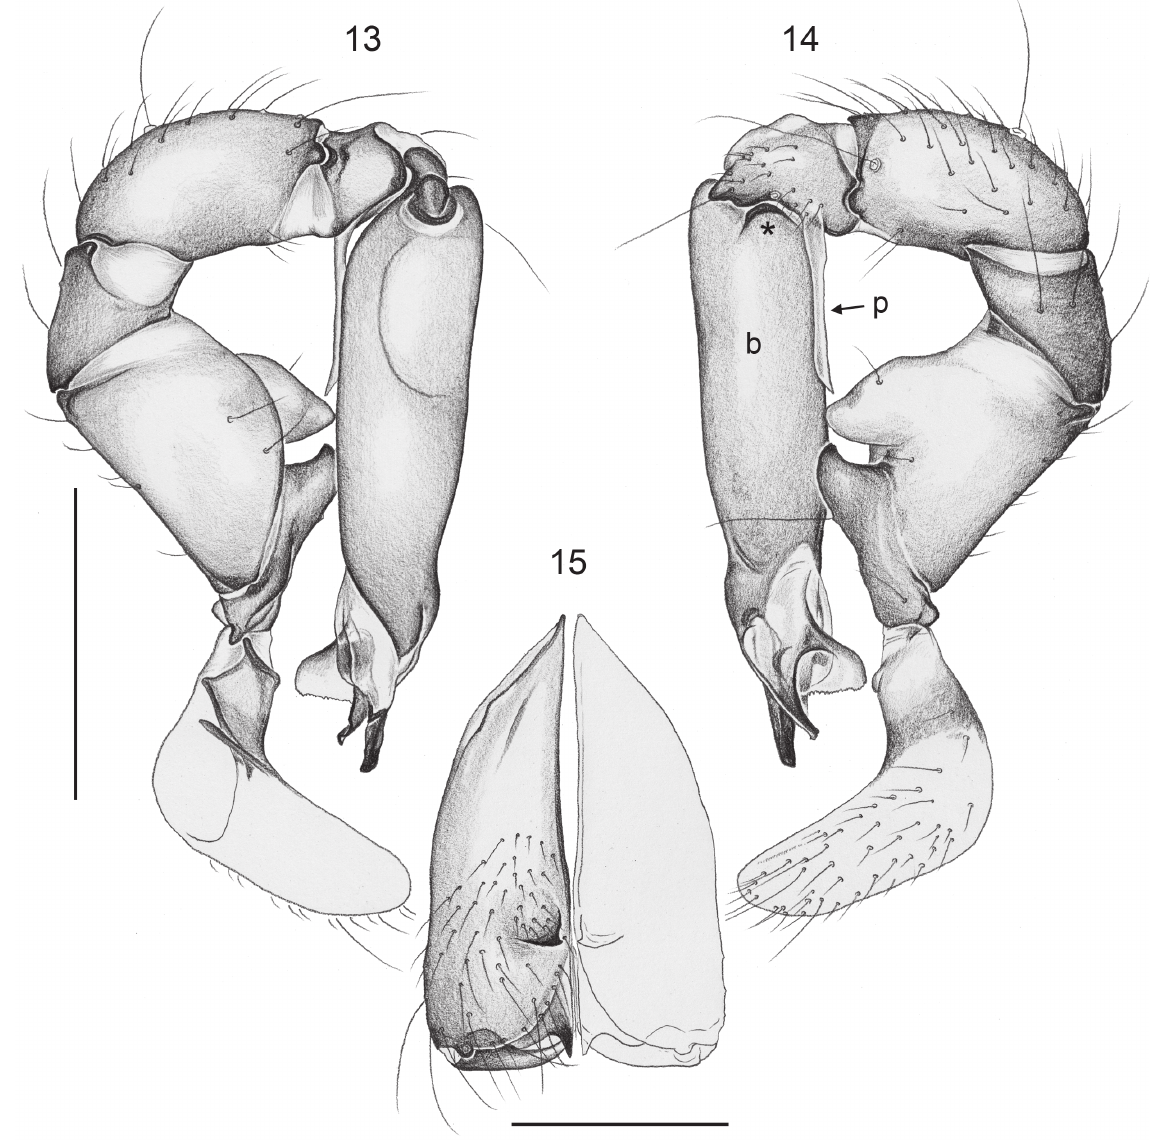
Figs 13–15. Aetana ocampoi Huber, sp. nov. 13–14 . Left male palp, prolateral and retrolateral views (asterisk: retrolateral process of bulb). 15 . Male chelicerae, frontal view. b = genital bulb; p = procursus. Scale lines: 13–14 = 0.5 mm; 15 = 0.2